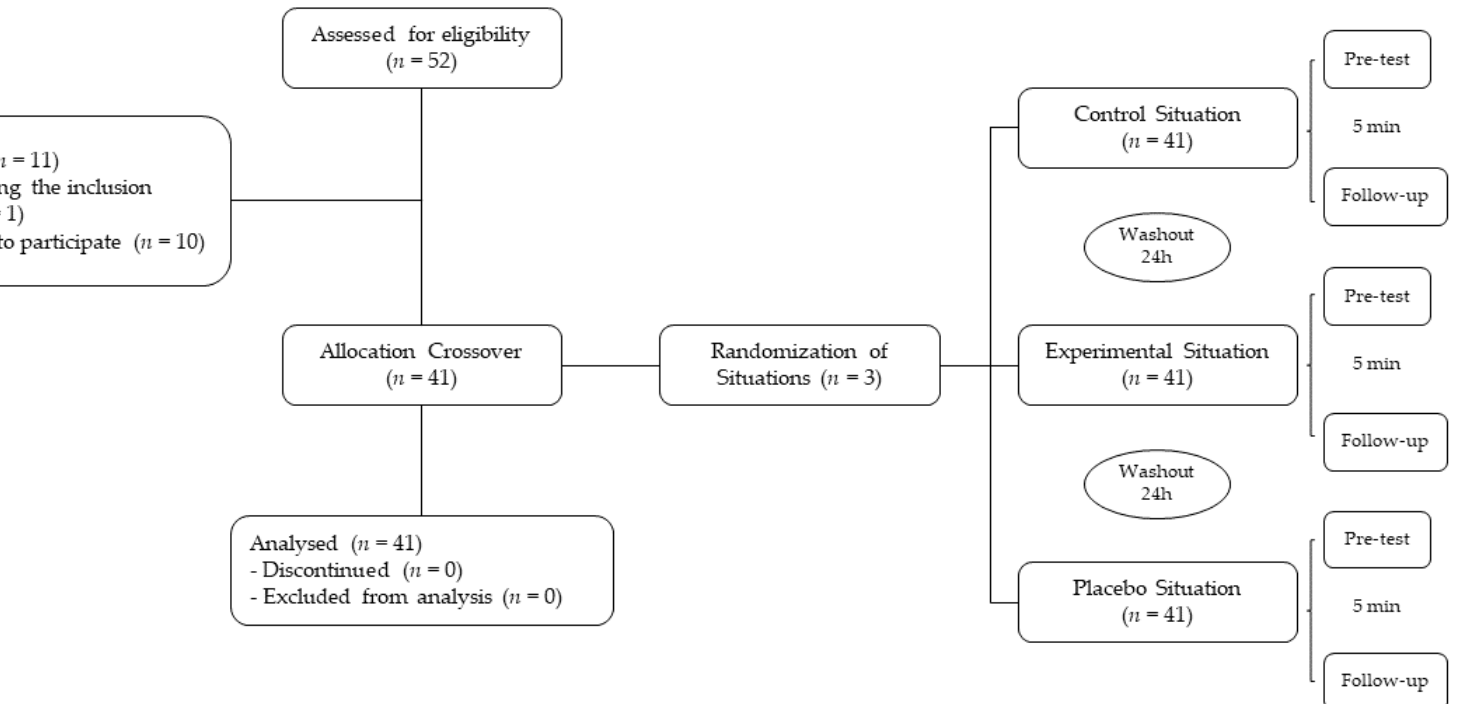
Figure 1. Flow of participants throughout in all stages of the research.